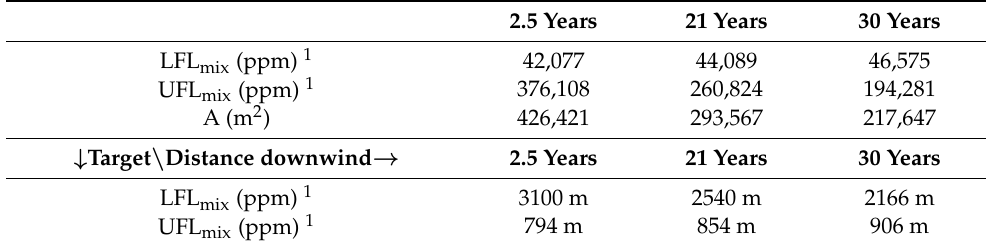
Table 6. Results of the Gaussian dispersion calculations, target concentration and relative distance downwind at 2.5, 21 and 30